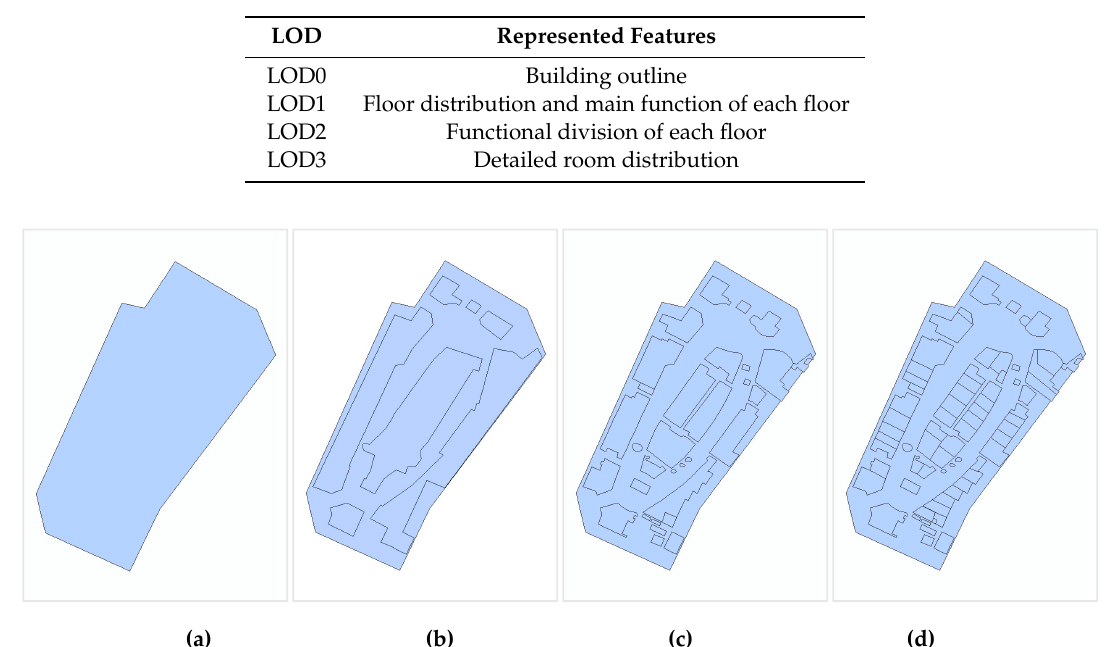
Figure 3. Multi-scale indoor map background data that indicate the functions of the indoor space at different levels: (a) LOD0; (b) LOD1; (c) LOD2; (d) LOD3 .